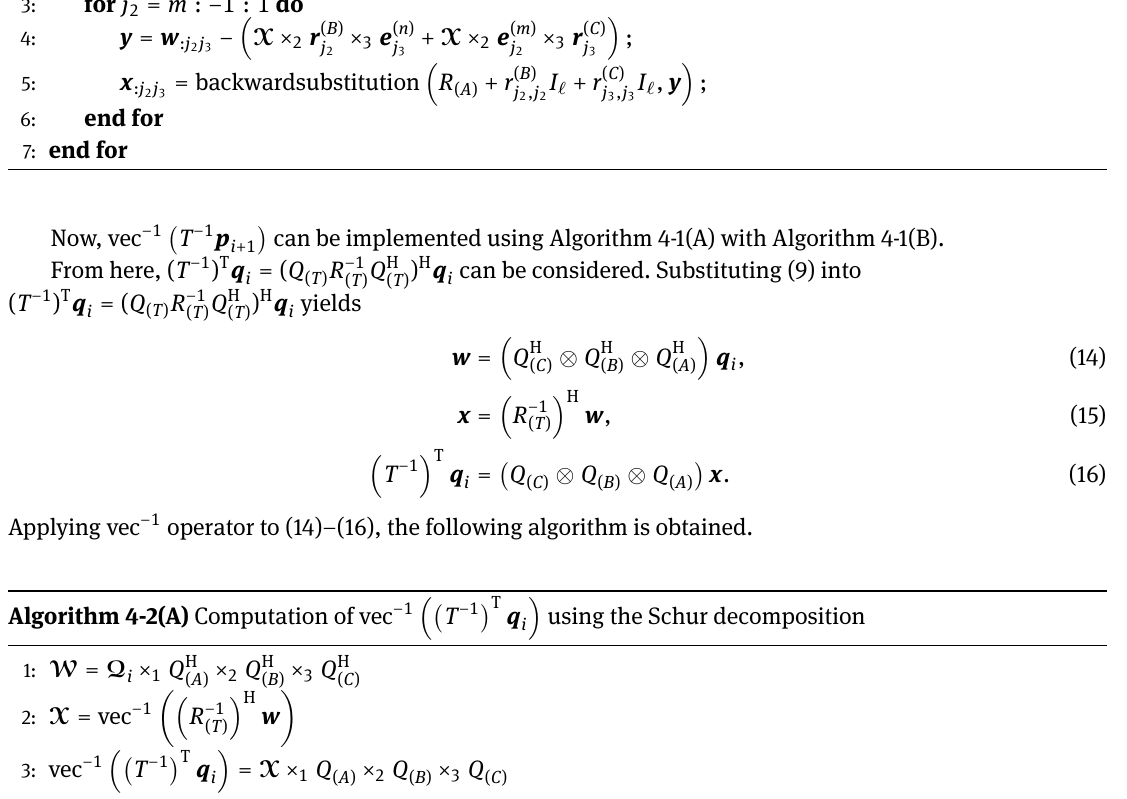
Algorithm 4-2(A) Computation of vec −1